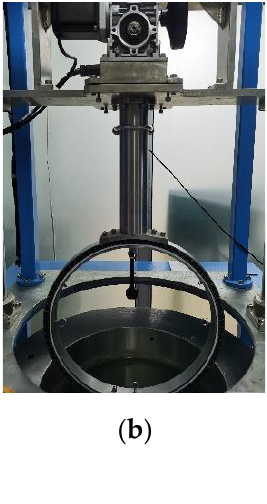
Table 1. The main parameters of FUVH.